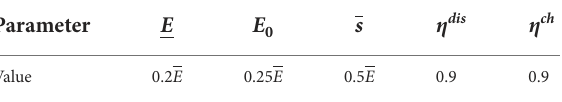
TABLE 3 Parameters of